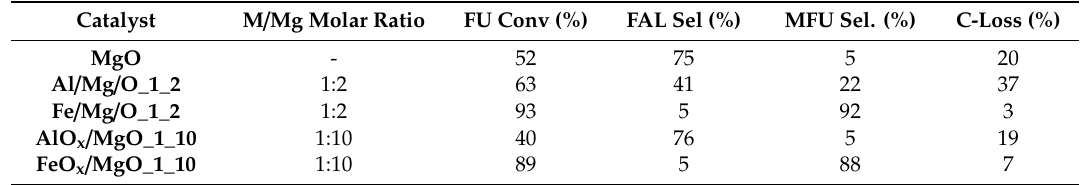
Table 3. Summary of the catalytic performance over di ff erent Al, Fe doping MgO catalysts.